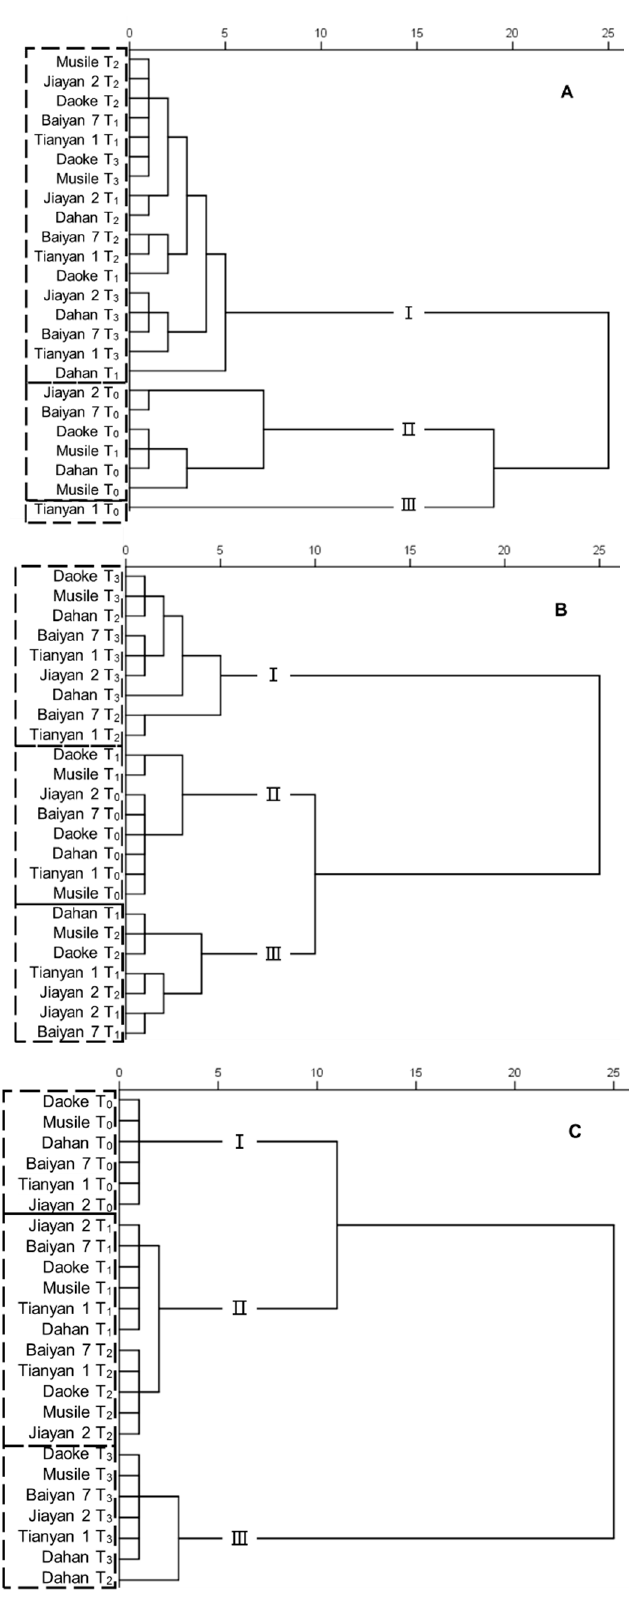
Figure 6. Cluster analysis of six oat genotypes grown in the given treatments. Variables were chosen from physiological traits studied in this work, including the water status traits P n , g s , E , WUE i , VPD, C i / C a and δ 13 C (abbreviations defined in Table 2) ( A ); the N metabolism traits δ 15 N, N concentration, NR and GS activity (abbreviations defined in Table 3) ( B ); and Ca 2+ , Mg 2+ , K + , Na + , and P concentrations ( C ).